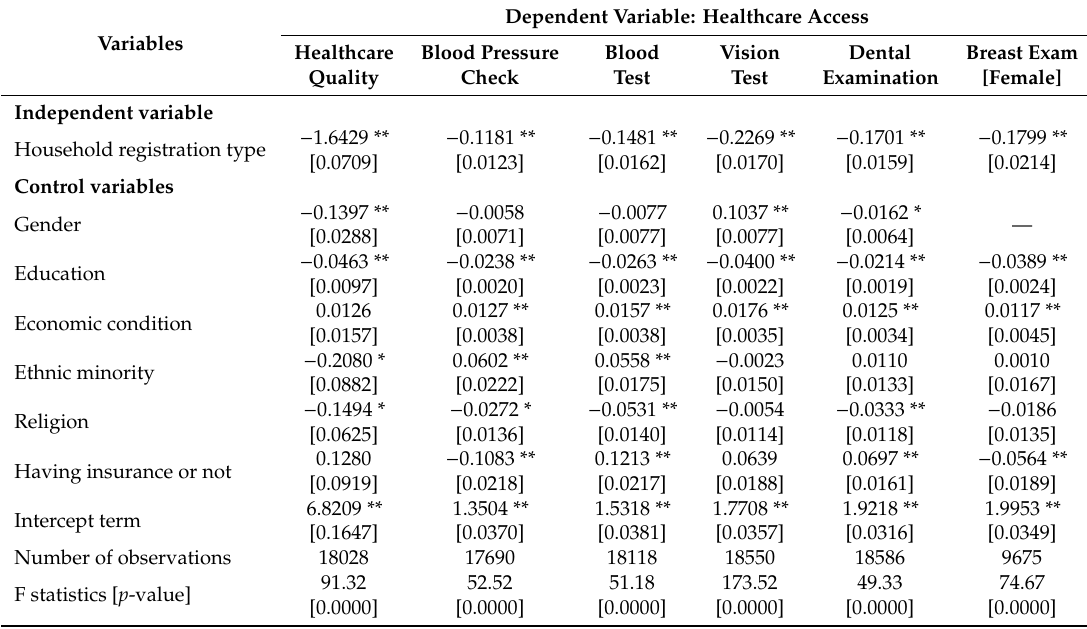
Table 3. E ff ect of household registration (hukou) type on healthcare